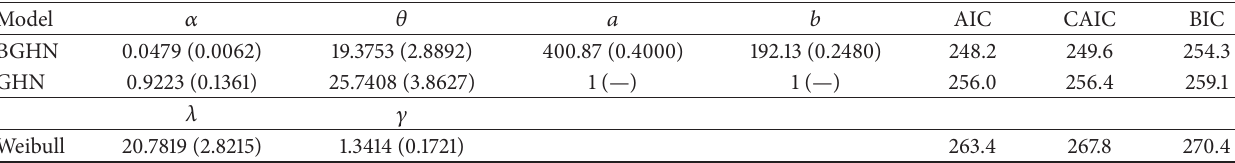
Table 2: MLEs of the model parameters for the transistors data, the corresponding SEs (given in parentheses), and the AIC, CAIC, and BIC